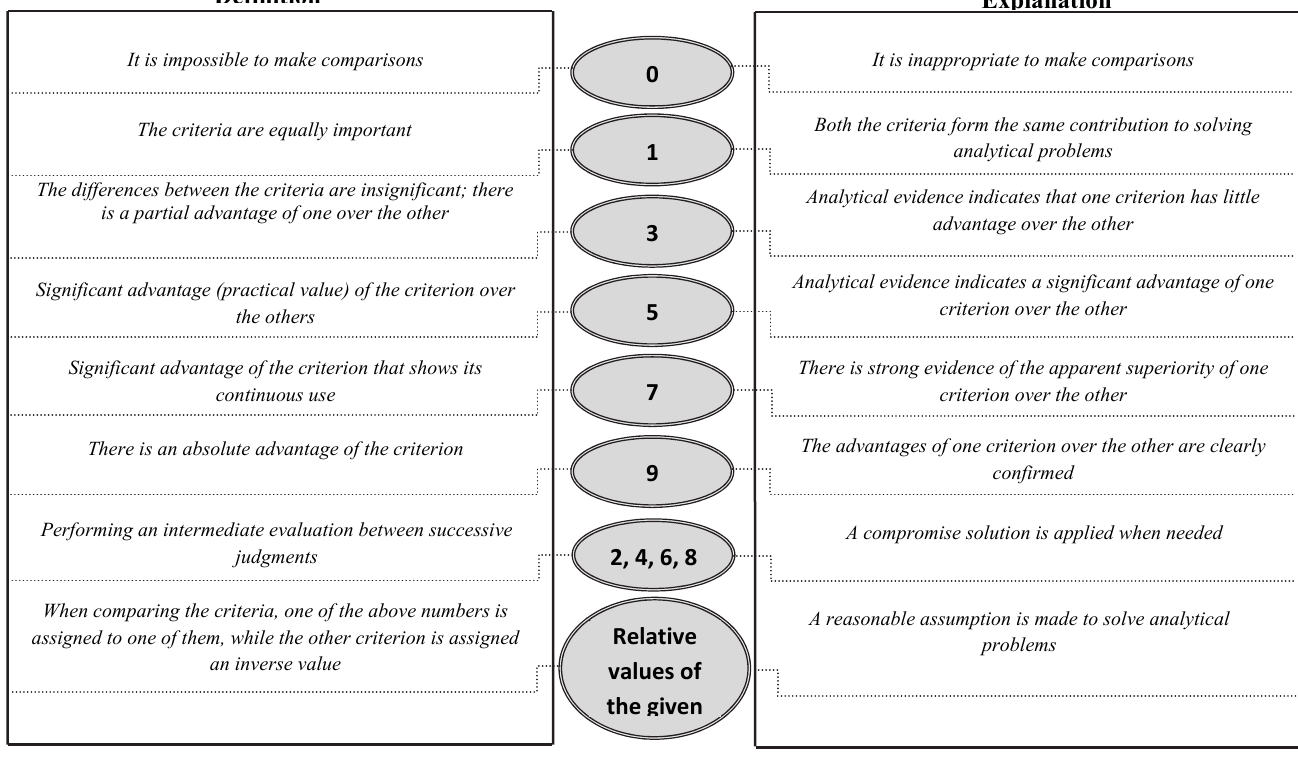
Fig. 1. Scale of assessing the relative importance of the competitiveness criteria